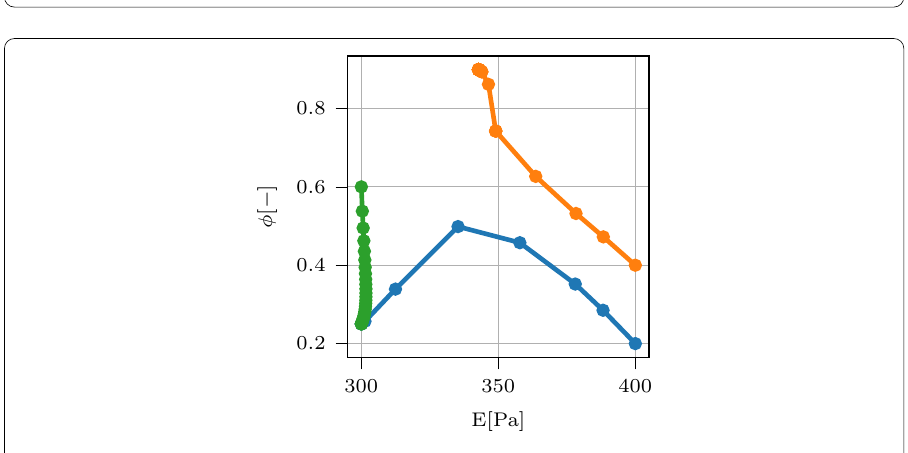
Fig. 17 Path in parameter space towards optimum for porous example Table5 Initial guesses for different inverse analysis runs in two-phase poroelastic example Color E 0 [Pa] φ 0 [ − ] Blue 400 0.2 Orange 400 0.4 Green 300